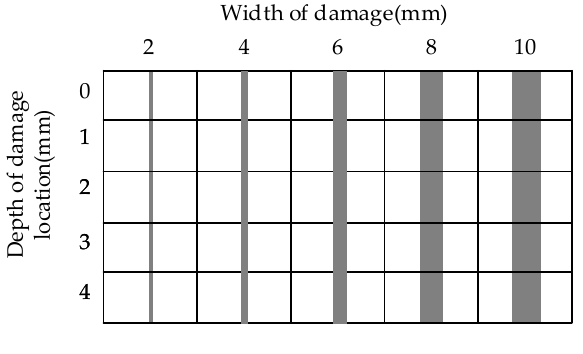
Figure 20. The distribution of samples.